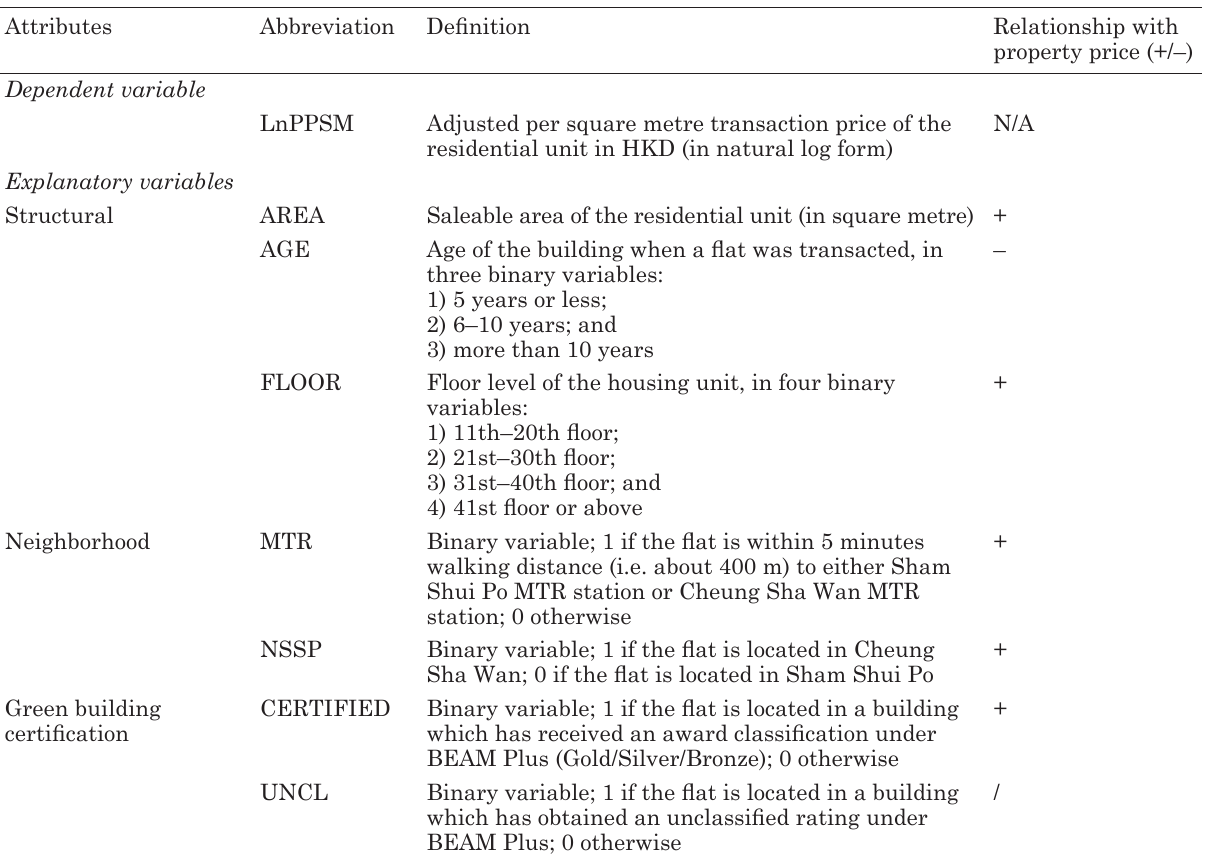
Table 6. A summary of variables and their expected relationship with housing